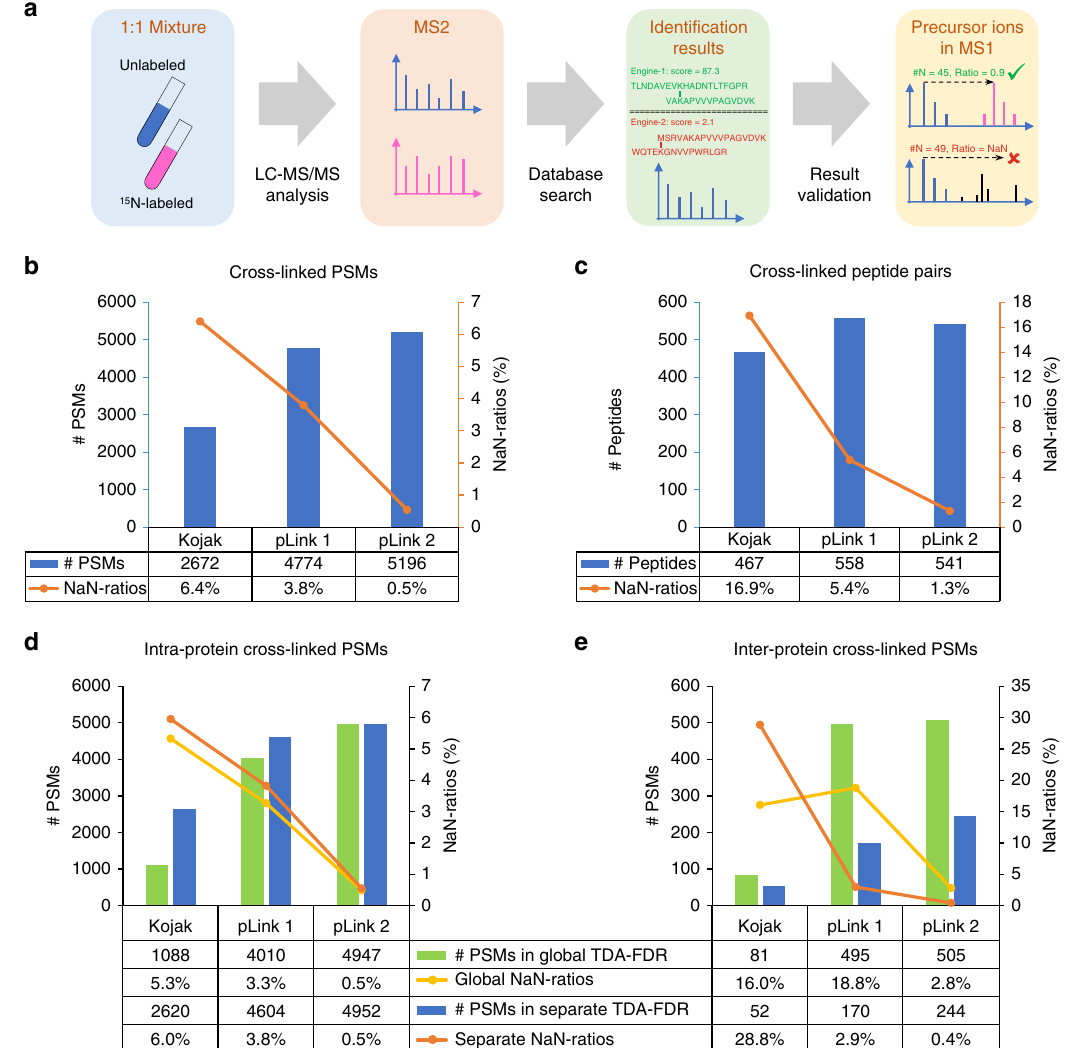
Fig. 3 Performance evaluation on the E.coli-Leiker- 15 N dataset. a Experimental design of the E.coli-Leiker- 15 N dataset. The unlabeled and 15 N metabolically labeled E. coli lysates were cross-linked separately, mixed at a 1:1 ratio, digested with trypsin, and analyzed by LC-MS/MS. The dataset was searched only for the unlabeled peptides using different search engines, and the identi fi cation results were passed to pQuant to quantify the intensity ratio of the 15 N- labeled precursor to the unlabeled precursor. Lastly, the precision of identi fi cations was investigated by checking the percentage of NaN-ratio PSMs and peptides. b Analyses of the identi fi ed cross-linked PSMs. c Analyses of the identi fi ed cross-linked peptide pairs. The histograms denote the total numbers of b PSMs or c peptide pairs identi fi ed by each search engine under separate FDR control of intra-protein and inter-protein results, and the curves denote the percentage of NaN-ratio b PSMs or c peptide pairs in the corresponding histograms. d For intra-protein PSMs, more results were reported under separate FDR control and its percentage of NaN ratios was slightly higher than that under global FDR control. e For inter-protein PSMs, many fewer results were reported under separate FDR control and its percentage of NaN ratios decreased, especially for pLink